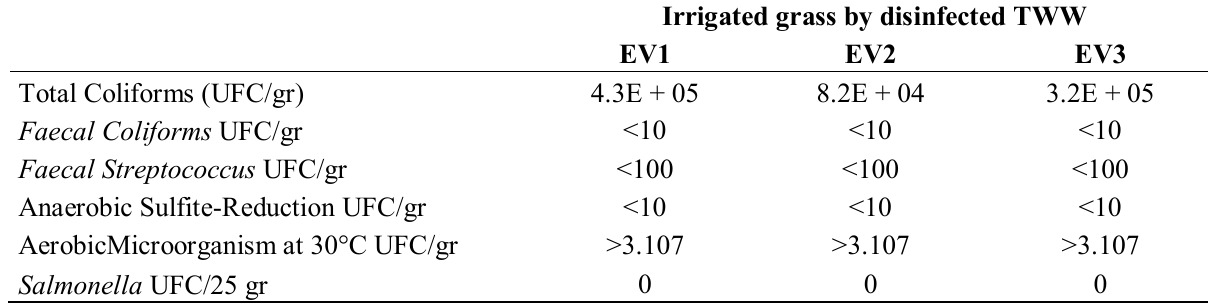
Table 7. Bacteriological tests of irrigated golf grass by disinfected treated wastewater at the end of the monitored 41